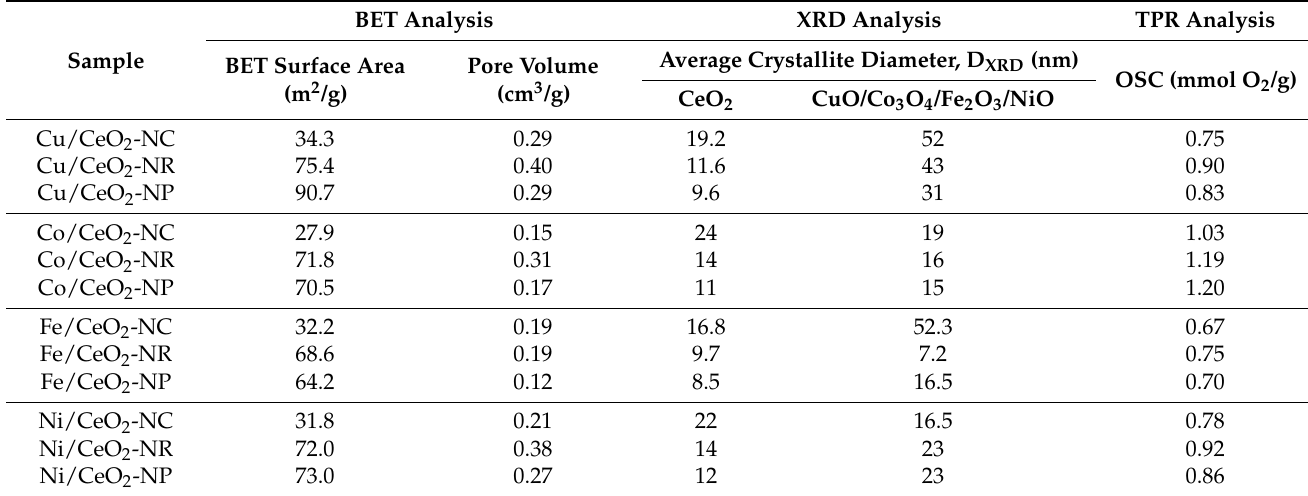
Table 4. Textural, structural and redox characteristics of ceria-supported transition metal